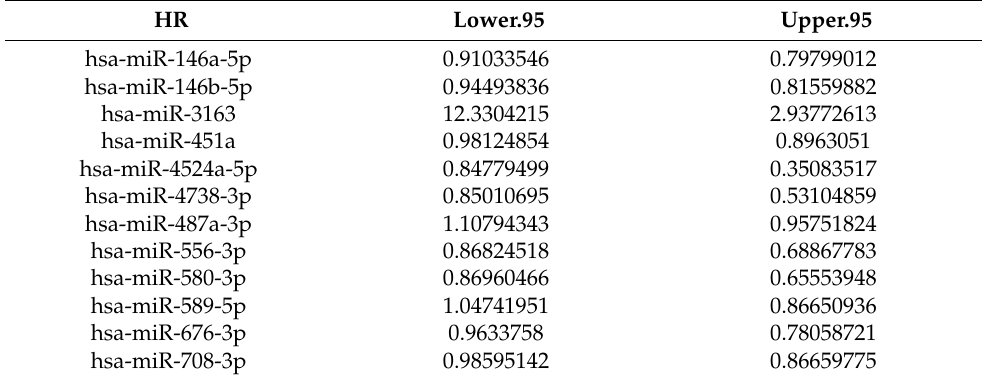
Table 4. Cos regression analysis of the 12 predicted miRNA from the ENCORI